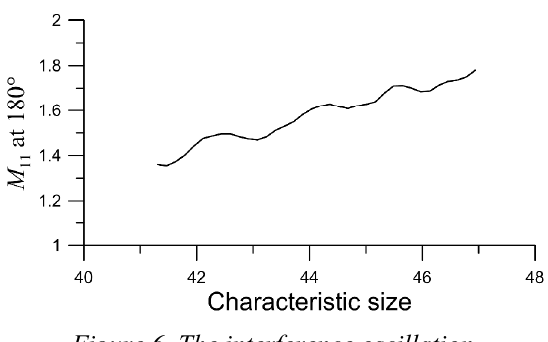
Figure 6. The interference oscillation